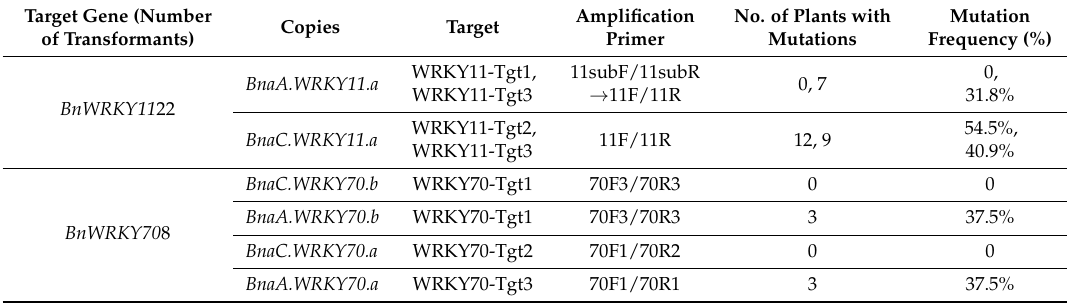
Table 1. The targets and primers designed for BnWRKY11 and BnWRKY70 and mutation rates in T 0